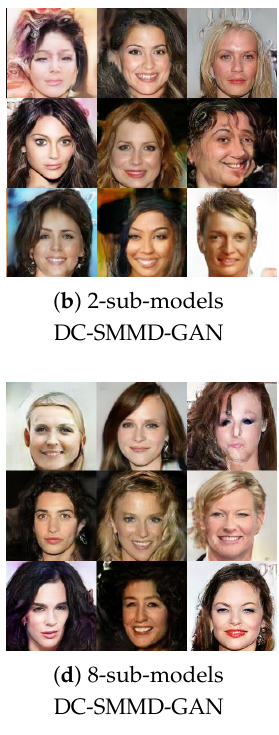
Figure 5. Images generated by different models trained on CelebA when the number of iterations is 15,000. DC-SMMD-GANs generate more realistic images while parts of images from the original models are blurred.